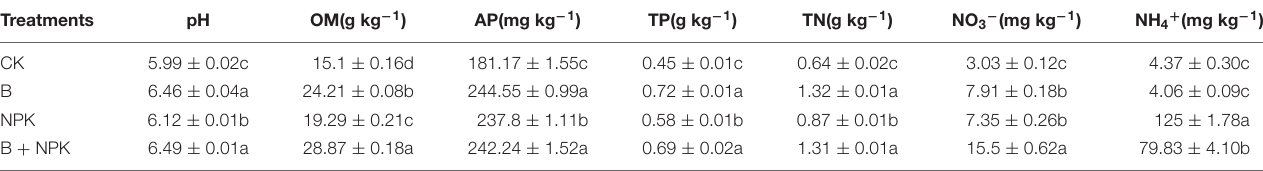
TABLE 1 | Chemical properties of rhizosphere soil under different treatments.